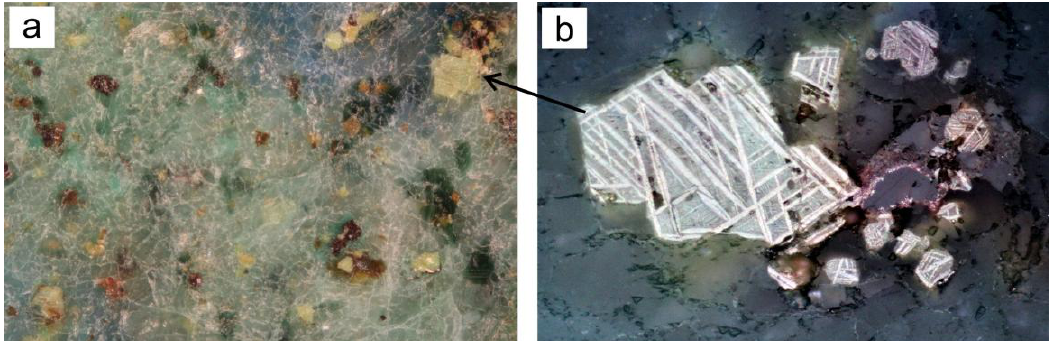
Figure 2. Details of a trachyte host rock fragment within a strongly foliated selenide veinlet (cf. Figure 1). ( a ) Interstices and heavily altered phenocrysts filled with greenish or bluish alteration products (malachite, azurite, or celadonite). Polished section, dispersed light dark-field image, width 2 mm. ( b ) Detail from Figure 2a (see black arrow) showing yellowish or brownish pseudomorphs consisting of a framework of oriented leucoxene lamellae originating in response to the alteration of titanomagnetite containing oriented ilmenite laths. Polished section, reflected light digital image, width 2 mm.